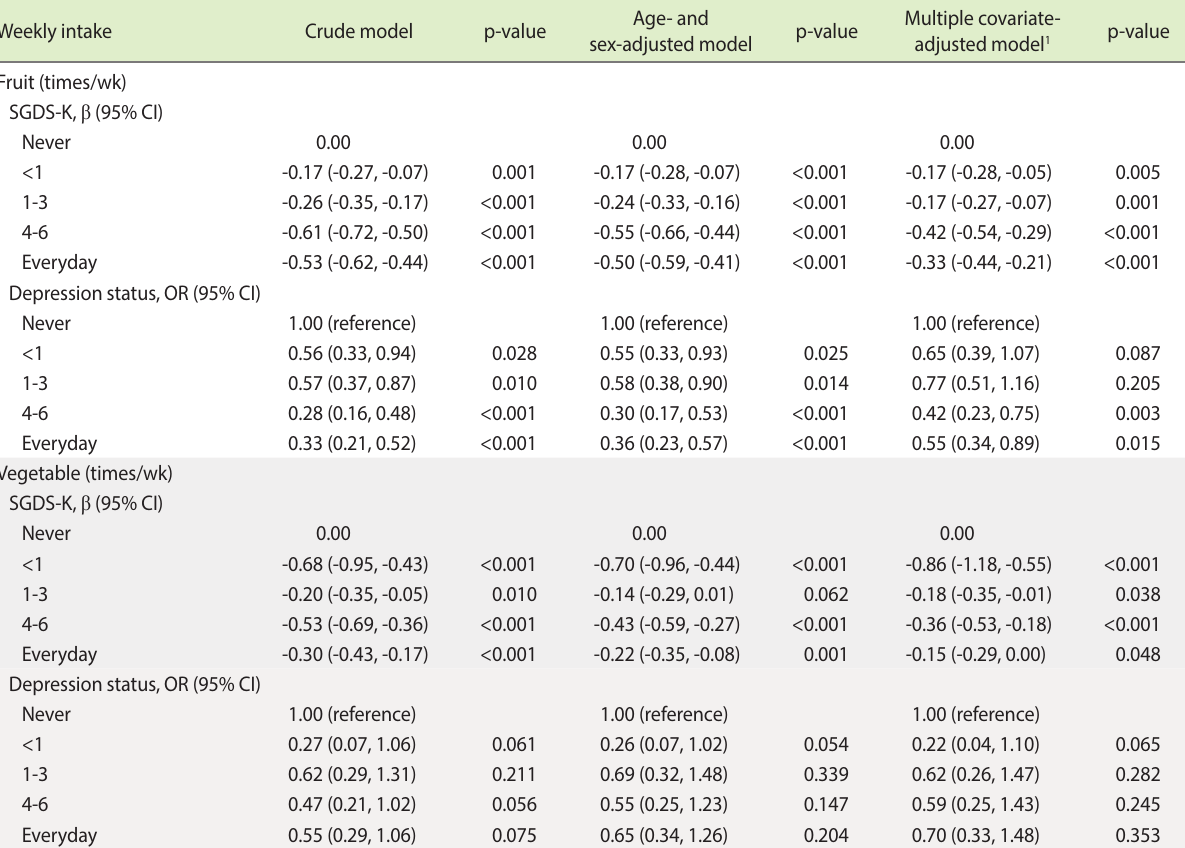
Table 2. Cross-sectional multiple linear regression models for the association of weekly fruit/vegetable intake with SGDS-K and